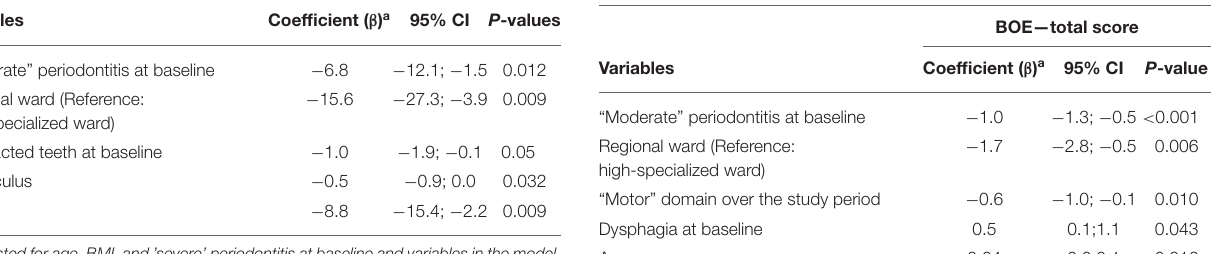
TABLE 3D | Mixed effect regression model comparing BOE data with systemic